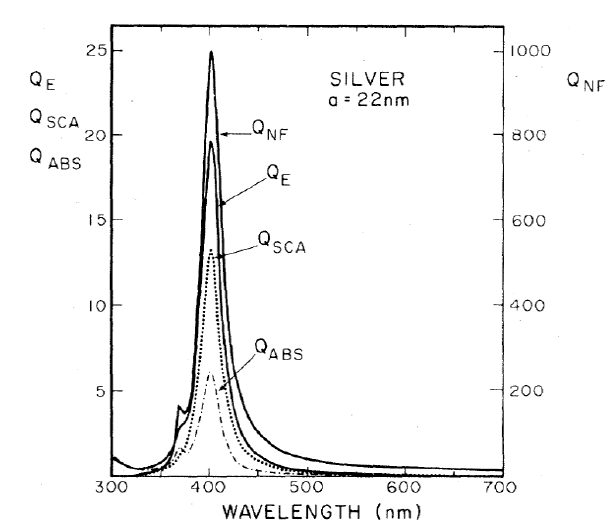
σ ω ) Sca ( and similarly π a 2 and similarly for the others). (cid:3095)(cid:3028) (cid:3118)